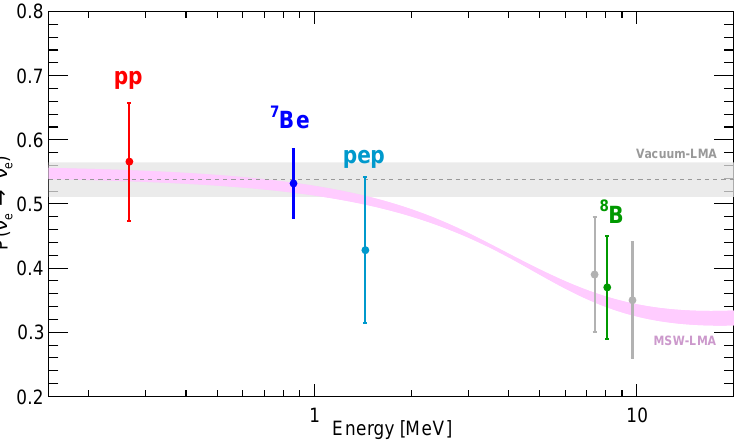
Figure 8. Electron neutrino survival probability P ee as a function of neutrino energy. The data points show the Borexino results, obtained assuming HZ-SSM flux predictions [54], for pp (red), 7 Be (blue), pep (cyan), and 8 B (gray for the separate HER-I and HER-II sub-ranges and green for the combined HER range). The error bars include experimental and theoretical uncertainties. The gray band corresponds to the P ee predicted by the vacuum-LMA scenario, while the pink band represents the MSW-LMA solution. The width of the bands is 1 σ . More details in text. From ±